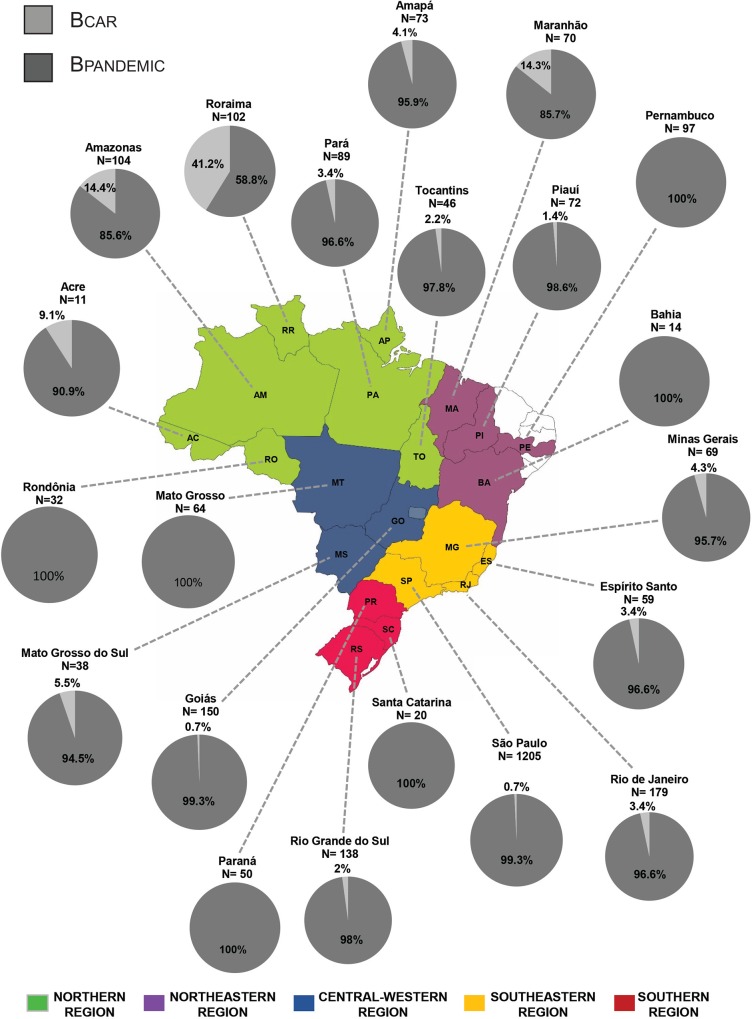
Estimated proportion of BCAR and BPANDEMIC clades among HIV-1 subtype B infected individuals from different Brazilian states.The total number of sequences analyzed in each locality is indicated. States were colored according to the Brazilian region of origin as indicated in the legend at bottom, with exception of those states with no HIV-1 sequences included in this study (white). Map was created from a template obtained from d-maps.com (http://d-maps.com/carte.php?numcar=4843&lang=en).